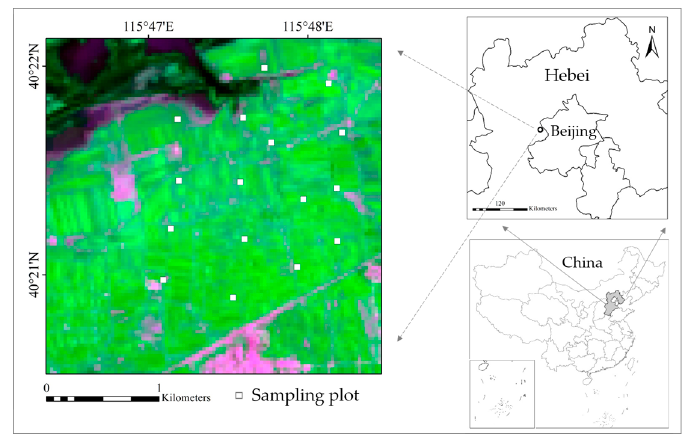
Figure 1. Location of the study area (false color composite Landsat 8 image acquired on 31 July 2013, R/G/B vs. band2/band5/band3), and sampling plots distributed in 3 km × 3 km area.